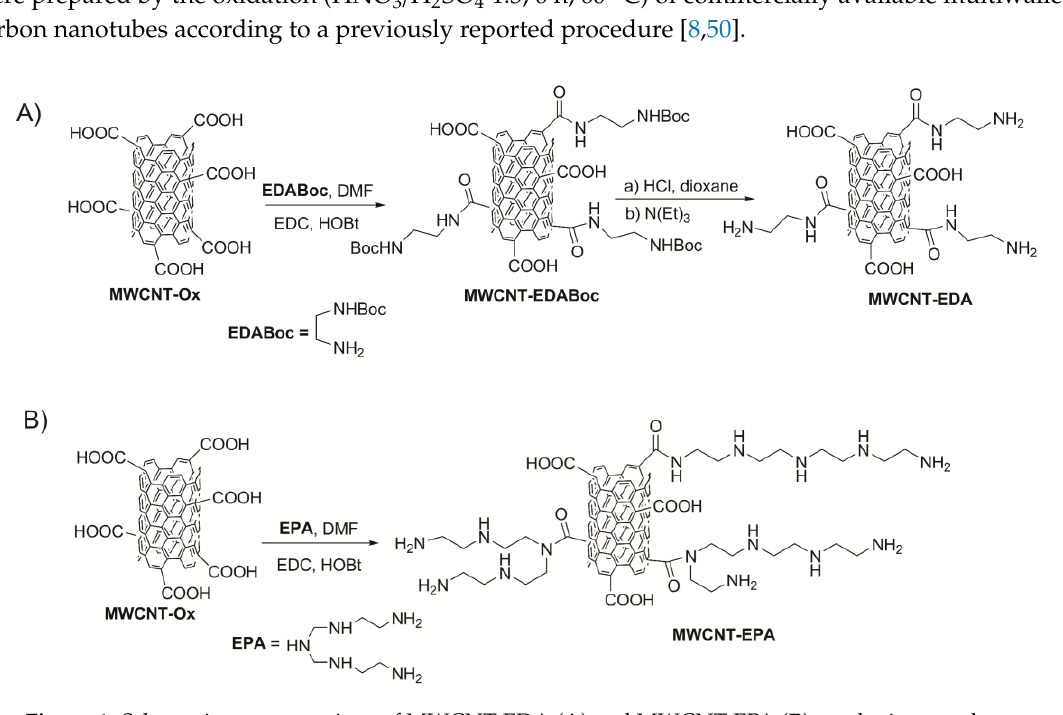
Figure 1. Schematic representations of MWCNT-EDA ( a ) and MWCNT-EPA ( b ) synthetic procedures.